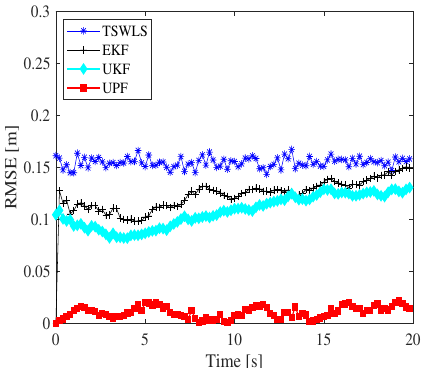
= 0.5 ◦ , σ = 0.1 m). d i i